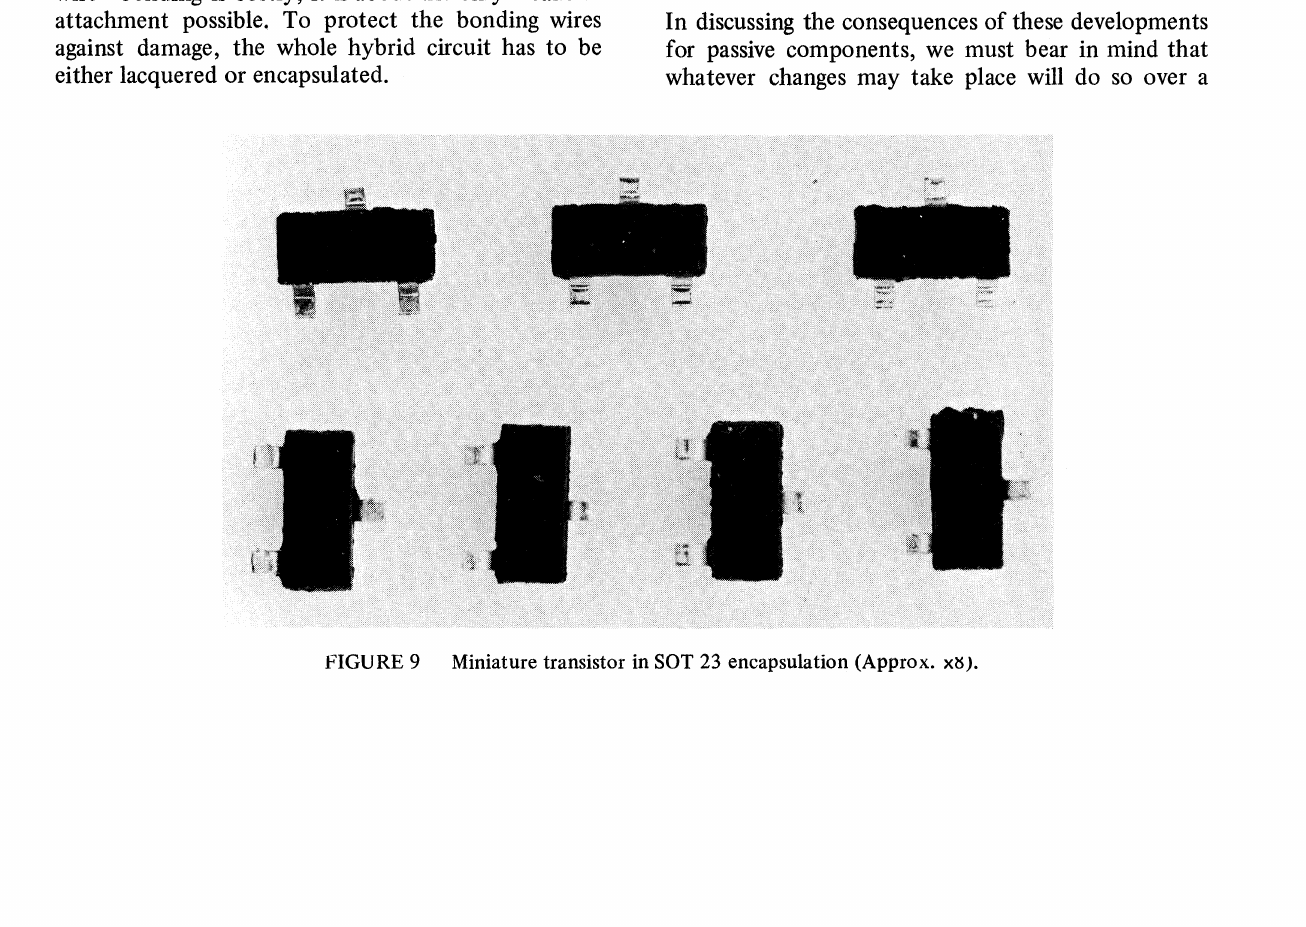
FIGURE 9 Miniature transistor in SOT 23 encapsulation (Approx.